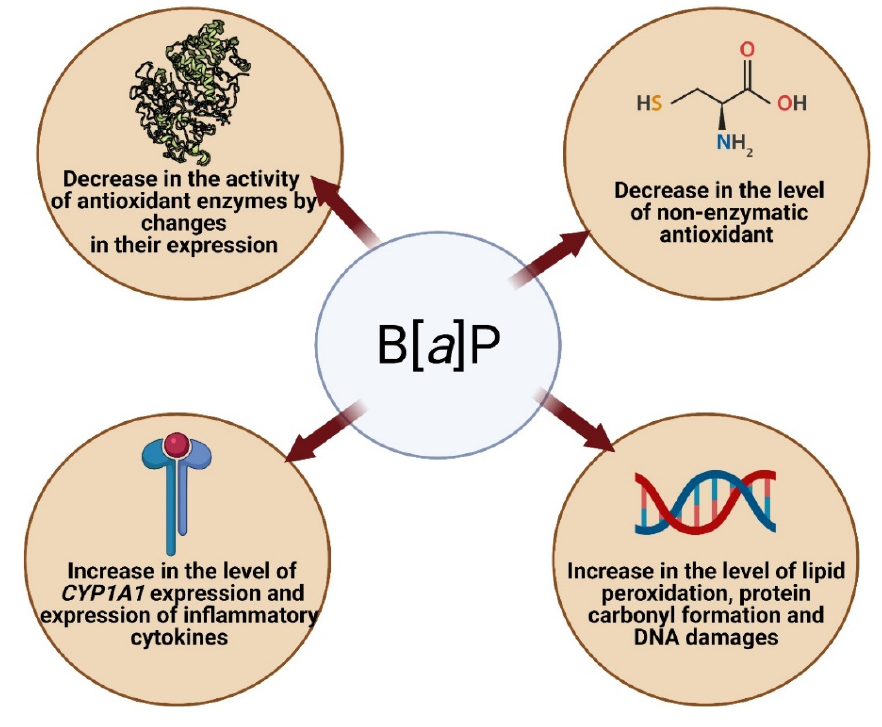
Figure 6. Pro-oxidative mechanisms of B[ a ]P action. Created with BioRender.com (accessed on 12 April 2022).